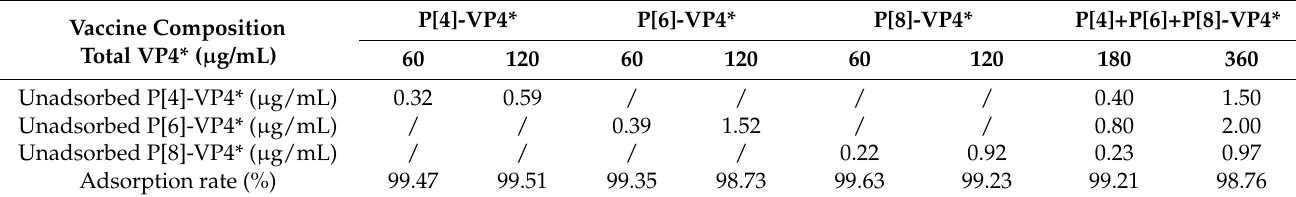
Table 1. The adsorption rate of VP4* antigens